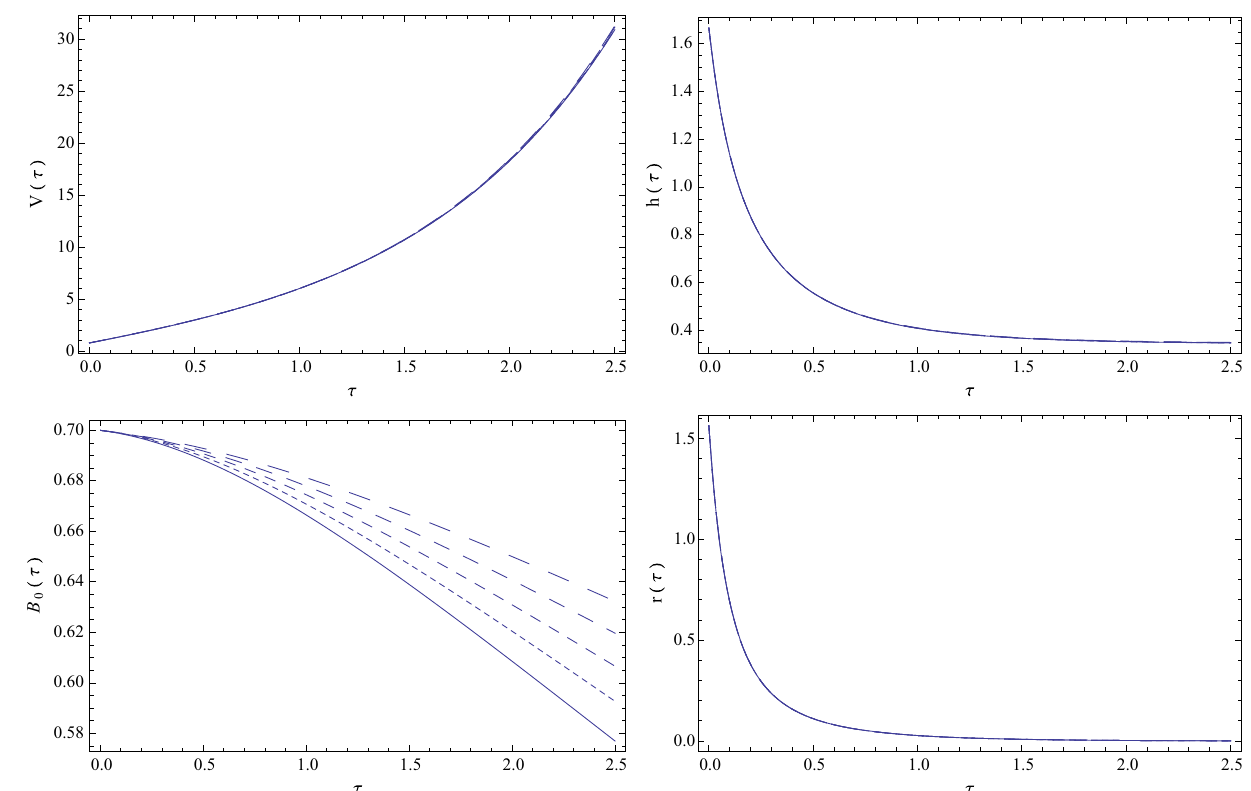
Fig. 1 Variationofthecomovingvolumeelement V ( upperleft figure), dashed curve ), λ 1 = 0 . 14, μ 0 = 0 . 301 ( dashed curve ), and λ 1 = 0 . 15, μ = 0 . 277 ( long dashed curve ), respectively. The initial conditions of the mean dimensionless Hubble function h ( upper right figure ), of 0 the dimensionless vector field B 0 ( lower left figure ), and of the dimen- used to numerically integrate the cosmological evolution equations are V ( 0 ) = 0 . 8, u ( 0 ) = 4, B 0 ( 0 ) = 0 . 7,and b 0 ( 0 ) = − 0 . 001,respectively. sionless matter energy density r for a Bianchi type I Universe filled with a stiff fluid in the Maxwell–Chern–Simons theory, for different values In all cases the numerical value of the parameter λ 2 has been fixed as λ = 0 . of the parameters λ 1 and μ 0 : λ 1 = 0 . 11, μ 0 = 0 . 447 ( solid curve ), 2 λ = 0 . 12, μ = 0 . 377 ( dotted curve ), λ = 0 . 13, μ = 0 . 333 ( short 1 0 1 0